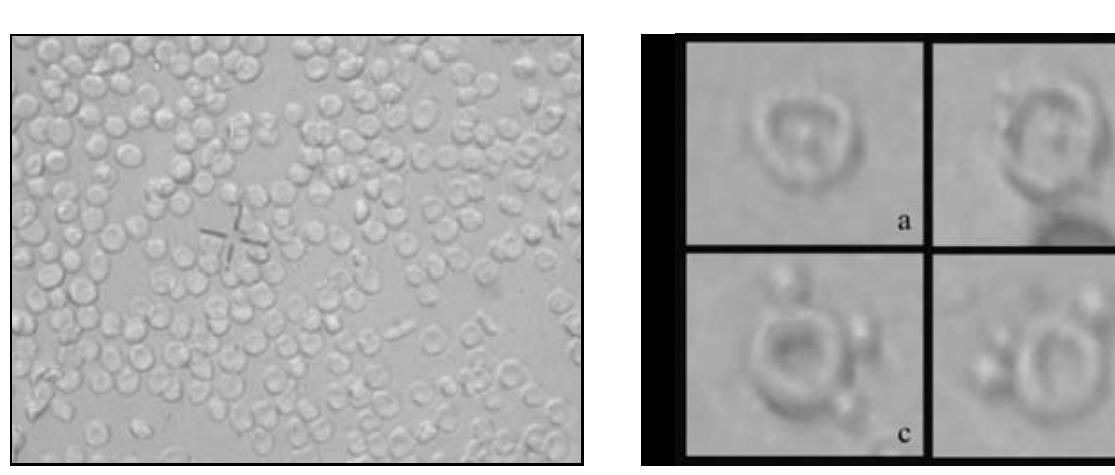
Figura 2 – Hemácias dismórficas presentes em hemorragias glomerulares. Codócitos (a, b) e acantócitos (c, d). Microscopia de contraste de fase